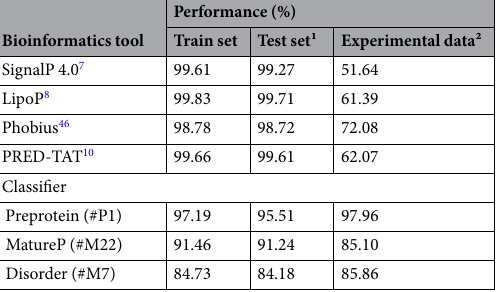
Table 1. Comparison with other bioinformatics tools. We measured the performance of four bioinformatics tools: SignalP 4.0 LipoP, Phobius and PRED-TAT on the training, testing and experimental datasets. We used the AUC as a performance metric 35 . AUC depicts relative trade-offs between true positive (benefits) and false positive (costs) and represents the performance of the average classifier (over different classifiers which assume different miss-classification cost ratios). ¹Randomly selected samples (20% of the total sample set; Table S1) which remained unused during the training of the classifiers. ²Experimental data manually collected from the literature (Table